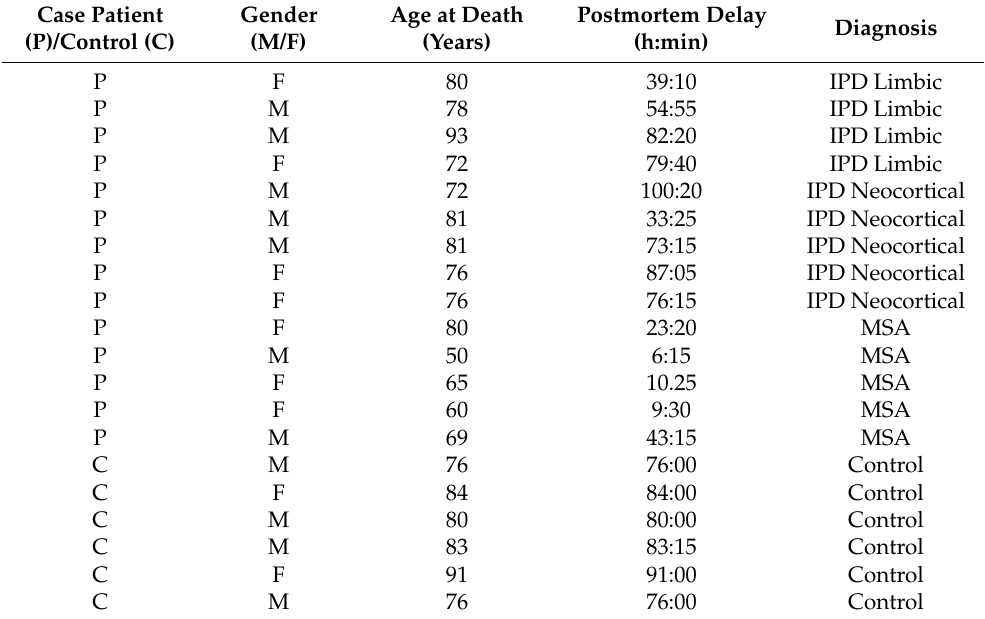
Table 1. Cont. Case Patient